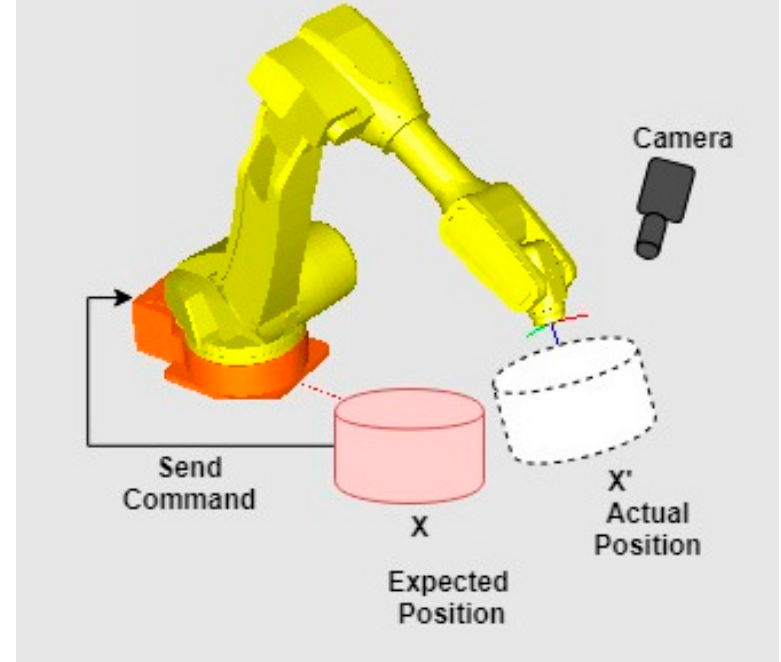
ff erence between expected and actual robot Figure 1. Difference between expected and actual robot position. Figure 1. Di